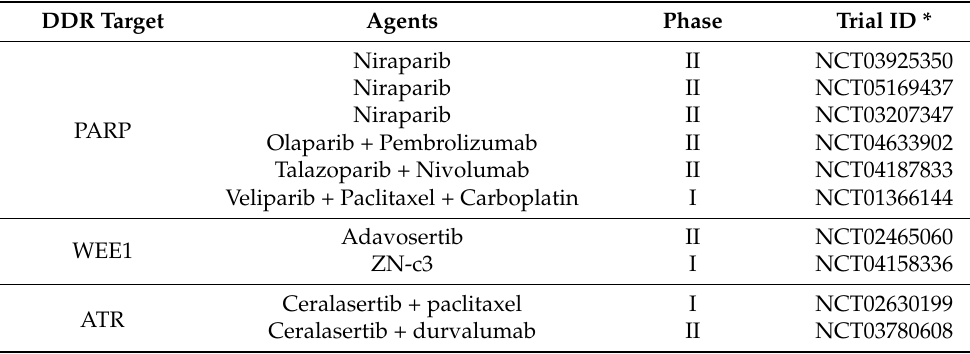
Table 2. DDR inhibitors currently undergoing clinical trials in